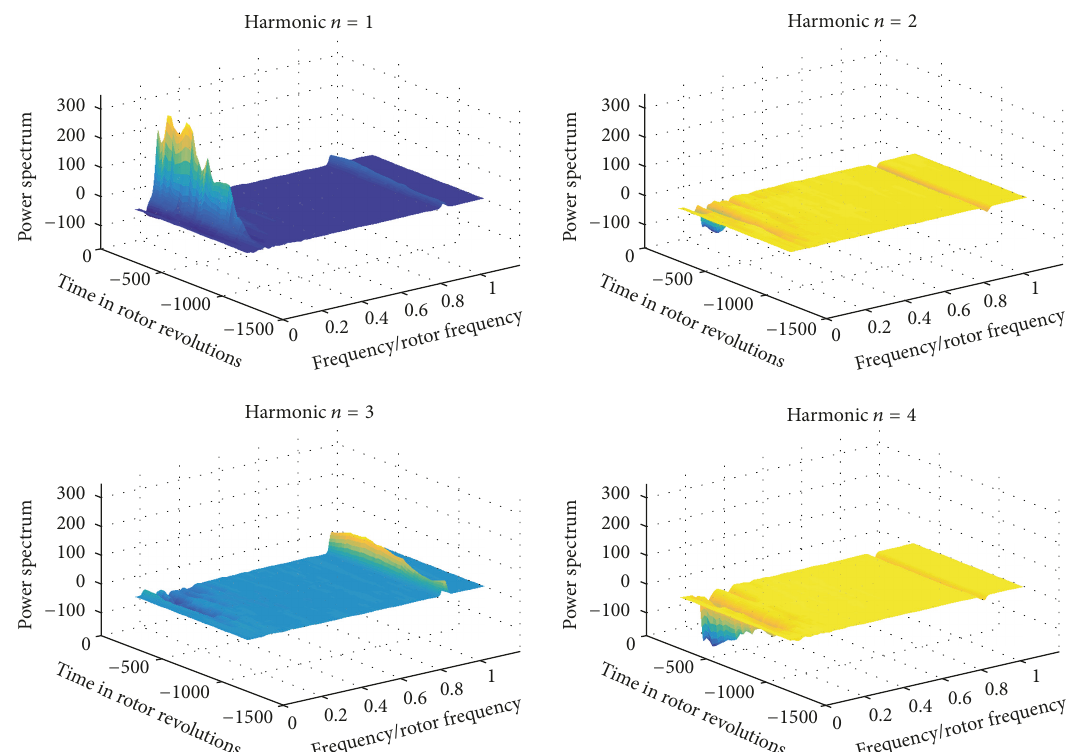
Figure 10: Spectrograms of the 1st, 2nd, 3rd, and 4th spatial harmonic pressure perturbations during stall ramp at 90% design speed with 120 kg/h steam injection.